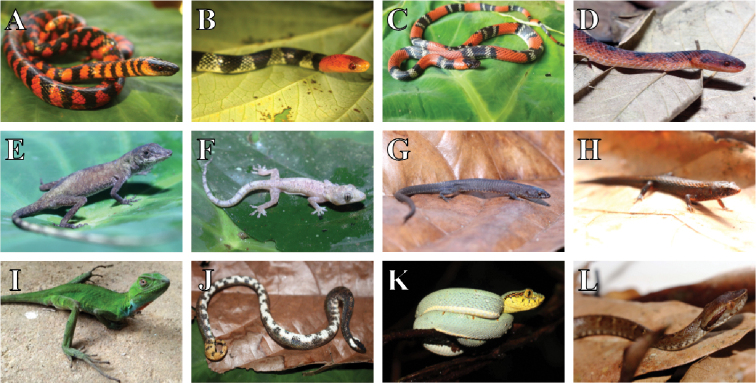
Reptiles recorded in the Parque Nacional da Serra das Lontras. AOxyrhopus
clathratusBO.
formosusCO.
guibeiDXenopholis
scalarisEAnolis
fuscoauratusFHemidactylus
mabouiaGLeposoma
nanodactylusHL.
scincoidesIEnyalius
catenatusJTropidophis
grapiunaKBothrops
bilineatusLB.
jararaca.